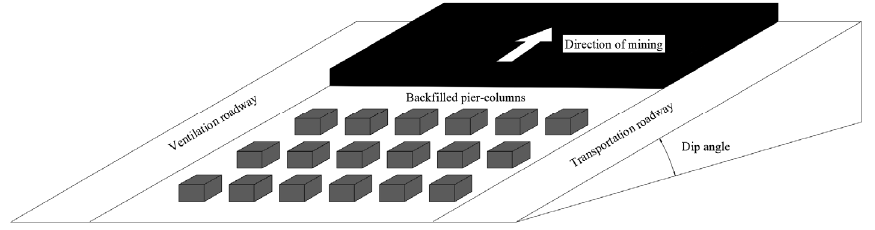
Figure 1. Schematic diagram of pier-column backfilling.